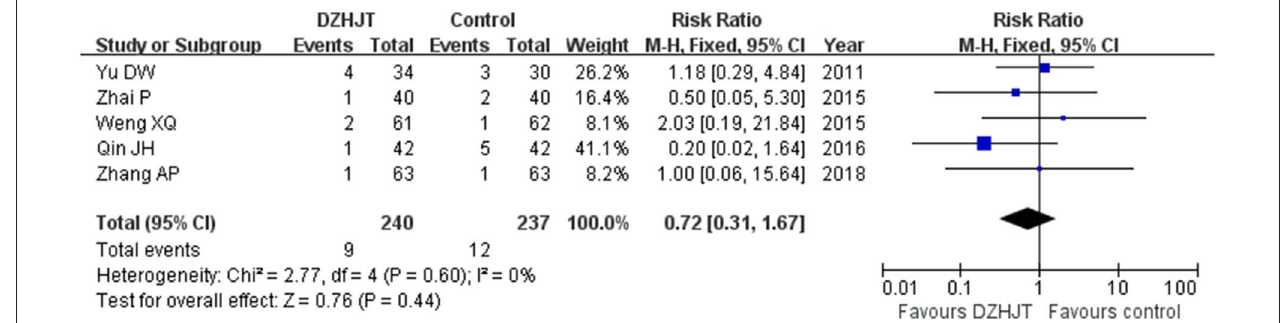
FIGURE 6 | Forest plots showing comparison of incidence of headache/dizziness in patients with or without DZHJT